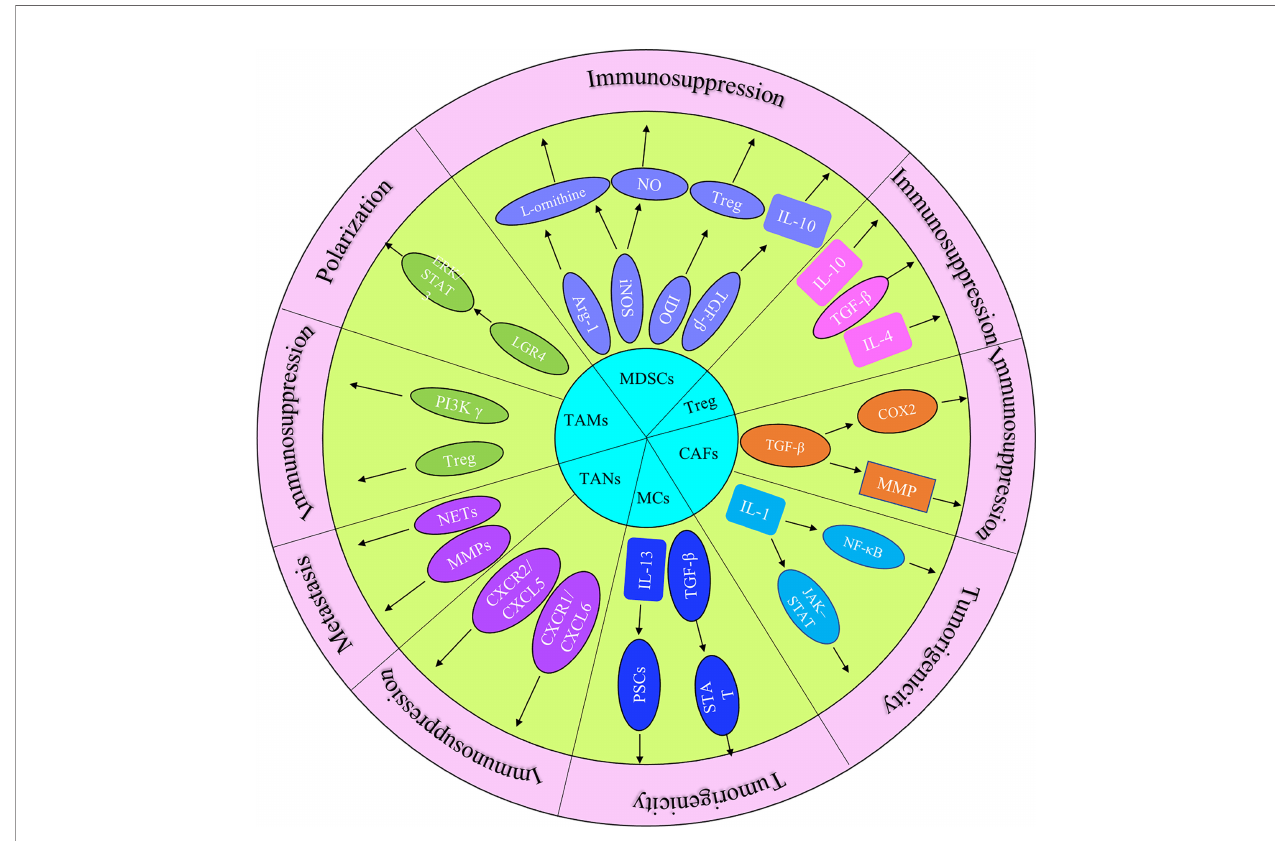
FIGURE 1 | The role of principal cytokines and stromal cells (MDSCs, CAFs, TAMs, TANs, Treg and MCs) that coordinate the tumor-promoting and immunosuppressive effects in pancreatic cancer